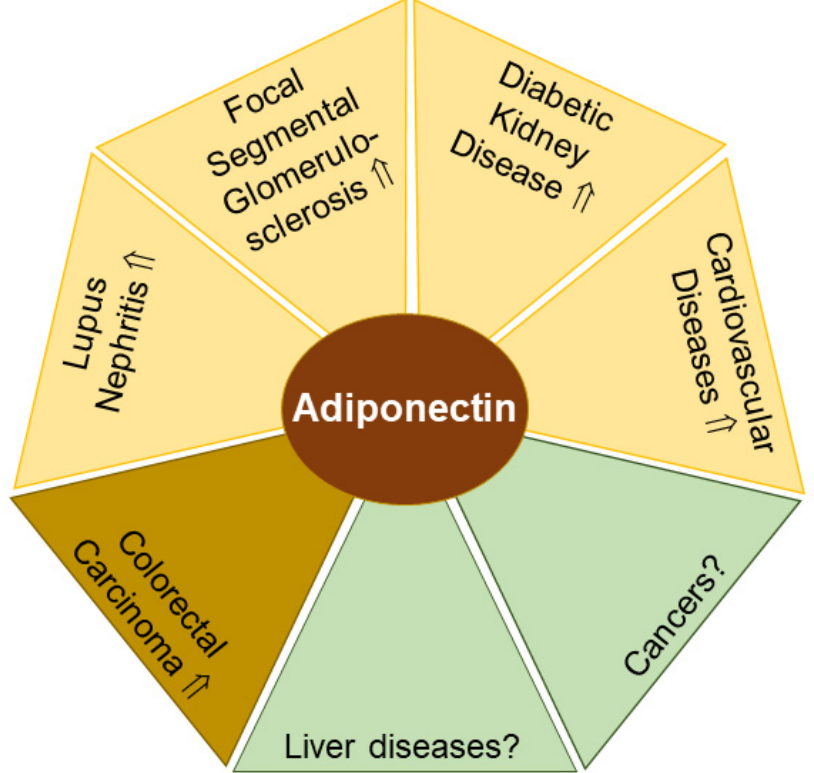
Figure 1. Adiponectin levels in urine (yellow) and feces (light brown) have potential to serve as biomarkers for the indicated diseases. In liver diseases and cancer (green) with altered circulating adiponectin levels, the diagnostic and prognostic value of urinary and/or fecal adiponectin remains to be clarified. Elevated ( ⇑ ) adiponectin levels and a lack of data on adiponectin amounts (?) in urine or feces in patients compared to the respective controls are indicated.